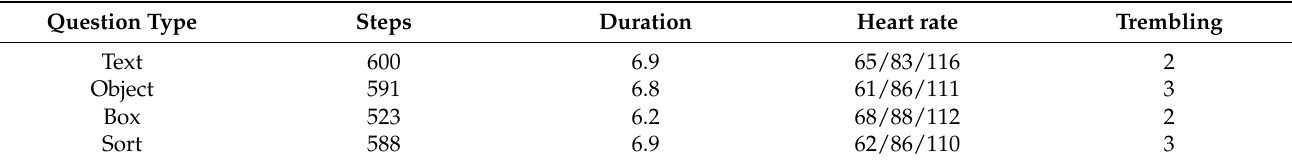
Table 6. Average results of different challenges in 10 sessions for 15 users aged 40–60.